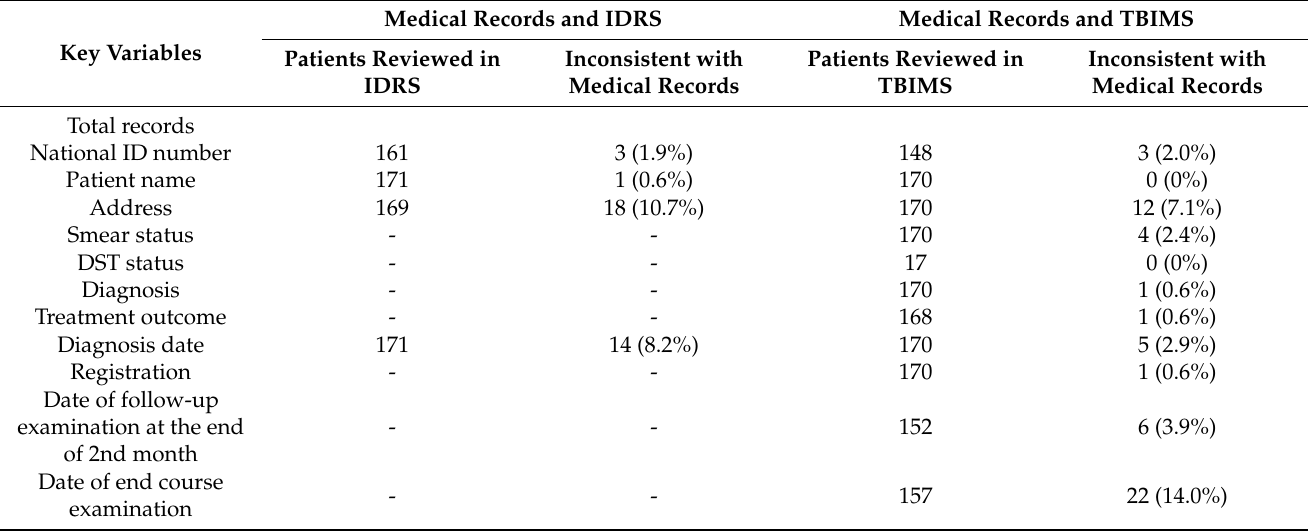
Table 5. Concordance of key variables for diagnosed TB patients between facility records and TB surveillance systems (by